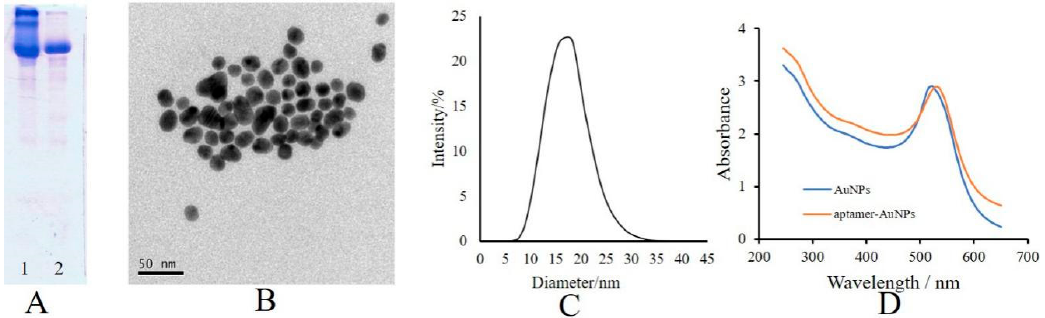
Figure 2. Results of material characterization: ( A ) SDS-PAGE of BSA and tetracycline-BSA; ( B ) TEM image of aptamer-AuNPs; ( C ) particle size distribution of aptamer-AuNPs; ( D ) UV–vis spectra of the AuNPs and aptamer-AuNPs.